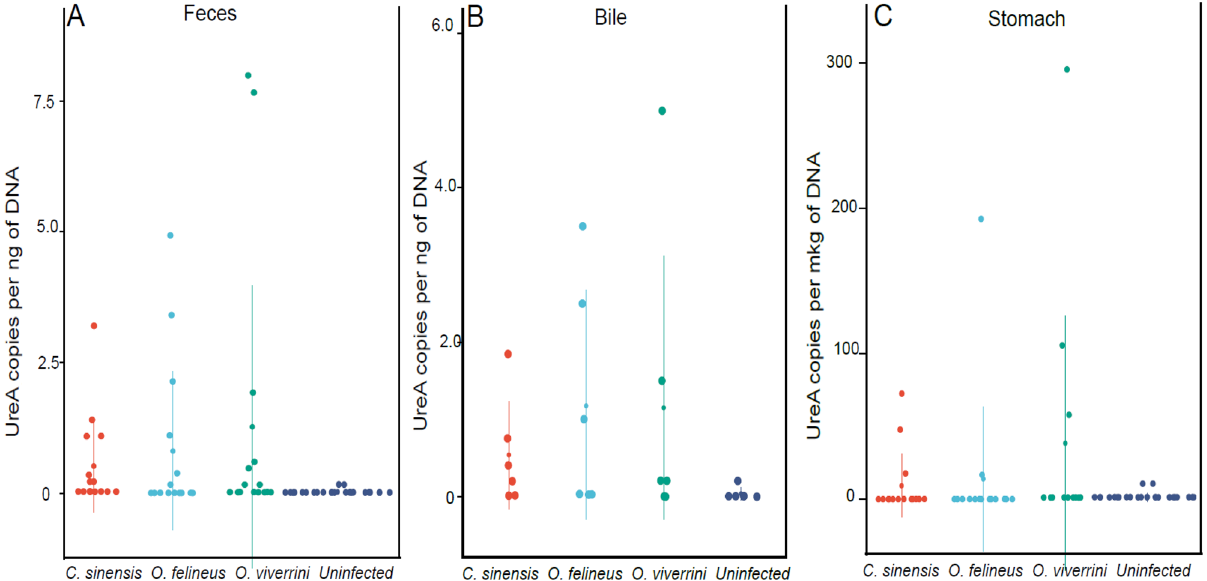
Figure 1. Quantification of H . pylori by quantitative RT-PCR in colorectal feces, stomach, and bile samples from uninfected hamsters and those infected with one of the liver fluke species. ( A ) Feces samples. ( B ) Bile samples. ( C ) Stomach samples. Tenfold dilutions of the pET plasmid carrying the H . pylori ureA gene were amplified in triplicate. A linear calibration curve was built to determine the mean starting amount of DNA in each sample and was found to have an R 2 value of 0.999. Gene copy numbers (meaning H . pylori cell counts) per microgram of DNA were determined by means of the standard curve at a crossing point in a graph of log concentration. The cell concentration and amounts of DNA were calculated to ensure the same initial DNA amount in each sample to be